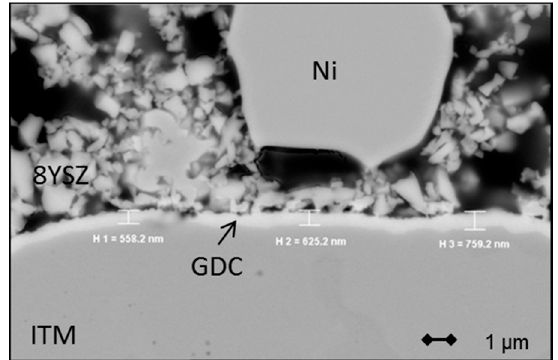
Figure 11. SEM image of a cross-section of an MSC with a magnetron sputtered GDC diffusion barrier layer covering the metal substrate.